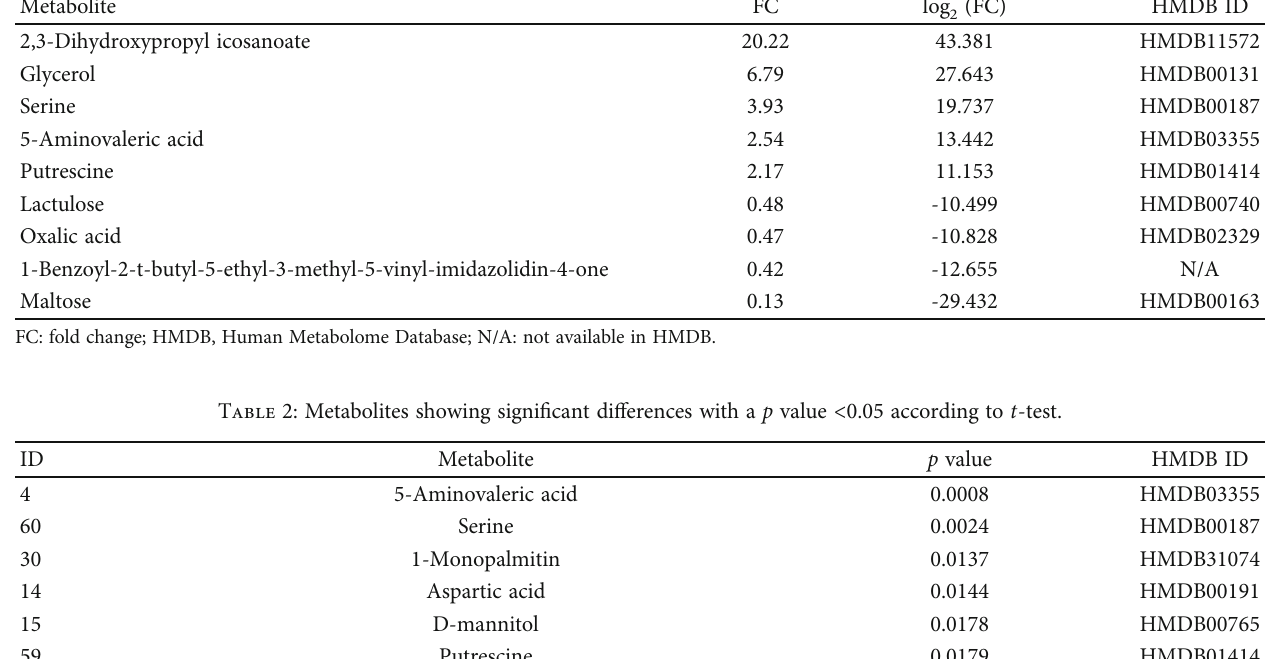
Table 1: Metabolites with a greater than twofold change in the periodontitis relative to the healthy group. Metabolite